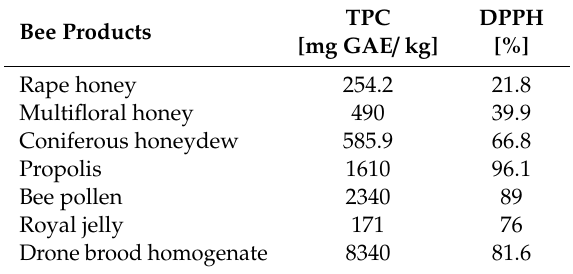
Table 3. Total phenolic compounds and antioxidant activity (DPPH) of the bee products [19,48–50].